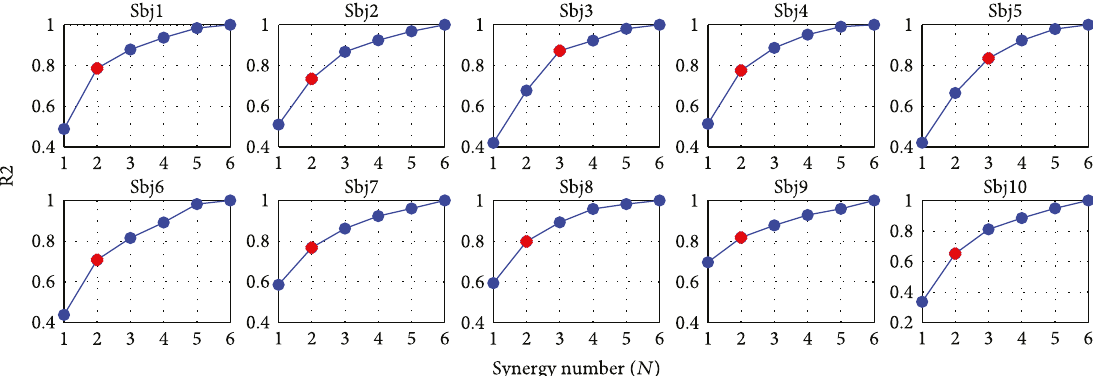
Figure 10: Activation reconstruction quality across synergy models per subject. The NMF algorithm was applied on each of the subject ’ s EMG data set while varying the number of synergies ( N ). The resulting curve depicts the r 2 values for each